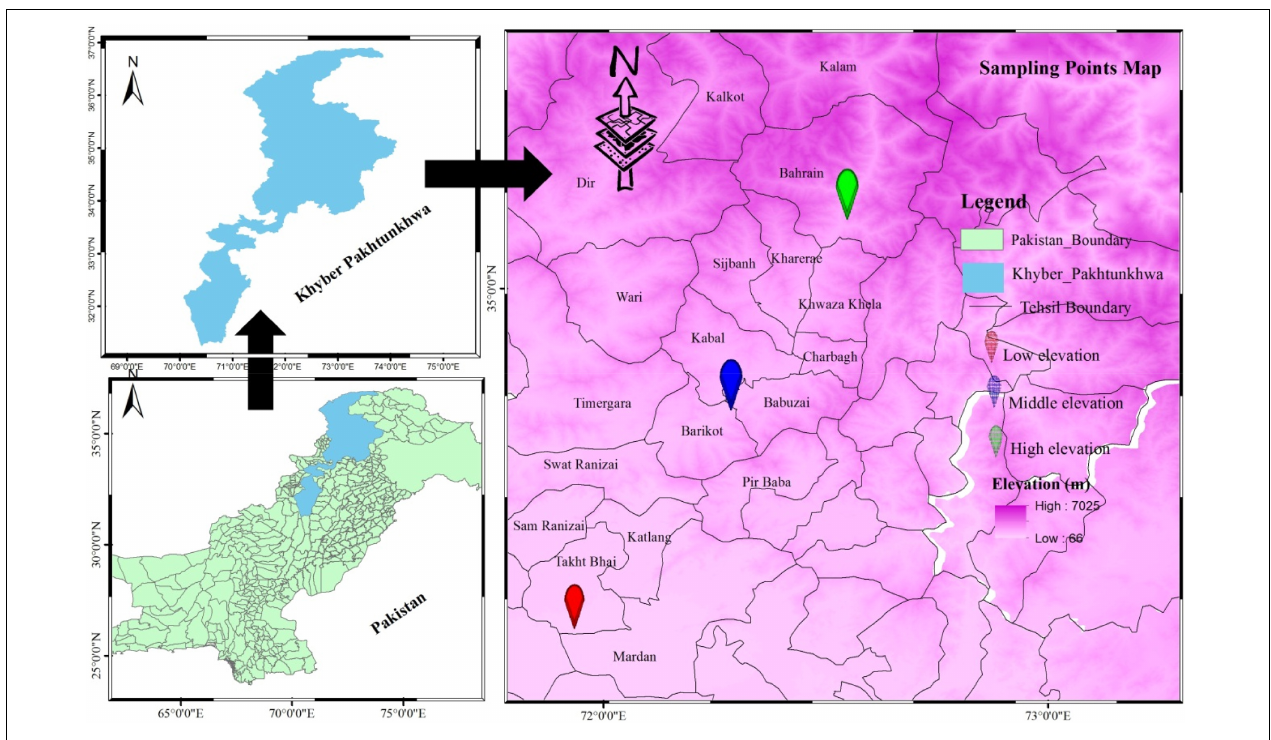
FIGURE 1 | Sampling area map revealing sampling points selected for phytosociological and traits analysis (morphological and biomass).